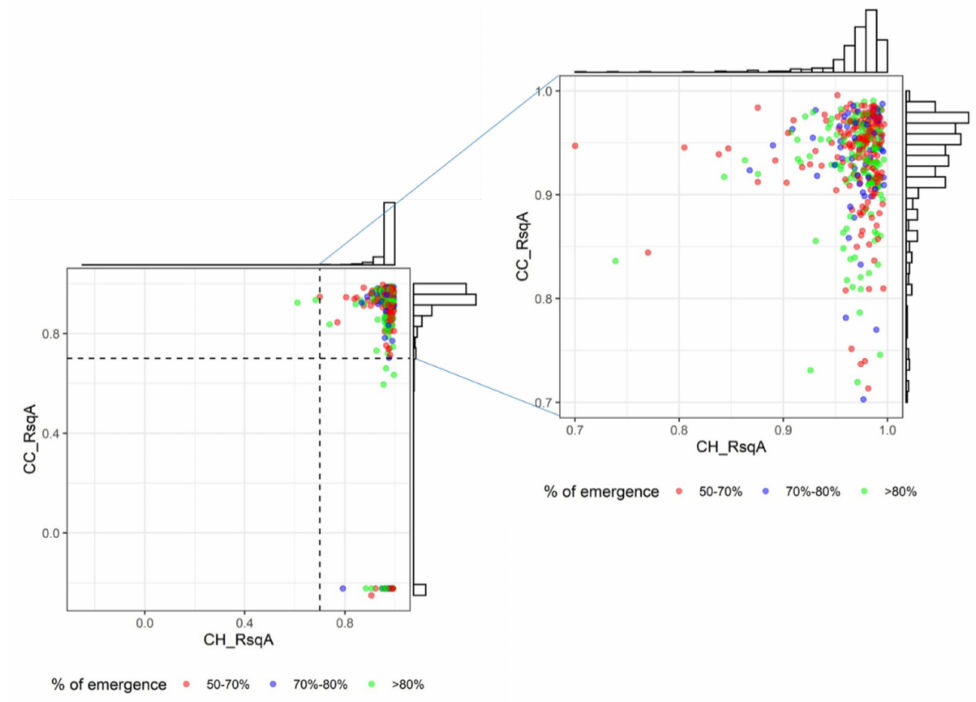
Figure 3. Adjusted R 2 of the curve fitting for canopy cover (CC_RsqA) and canopy height (CH_RsqA) data of all plots. A color code is used to show the percentage of emergence. Zoom of the plot distribution with an adjusted R 2 higher than 0.70 (n = 291 plots remaining for further analysis) is included. ◦ The parameter values for CC are presented in Table 2. For CC_tm ( C d) the median values ranged from 299 to 446; for CC_Cmax (%) the values ranged from 94.2 to 95.6. On average, CC_tm was lower for the later-sown groups GP3 and GP4 than for the groups GP1 and GP2 (Figure 4A). Table 2. Mean, median, standard deviation (Stdev) and coe ffi cient of variation (cv) of the phenotypic parameters derived from fitting the canopy cover data. Data are presented per group (GP1-4). For the abbreviations, see Table